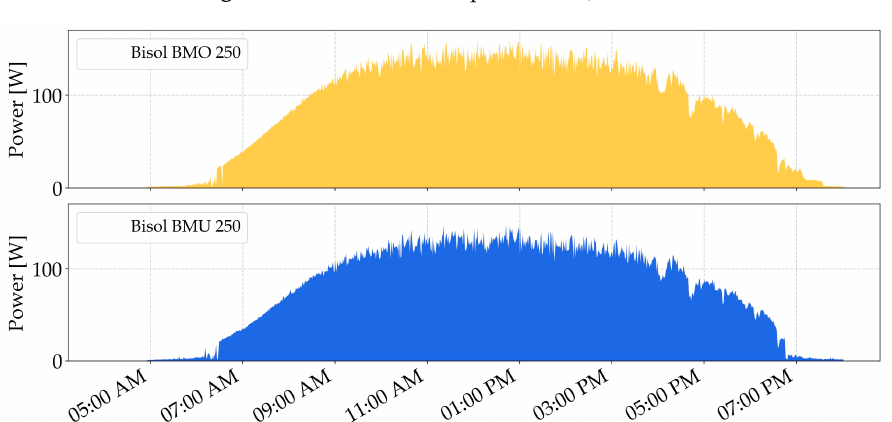
Figure 12. One-minute average values of output power of m-Si Bisol BMO 250 and p-Si Bisol BMU 250 PV modules on 4 June 2017.